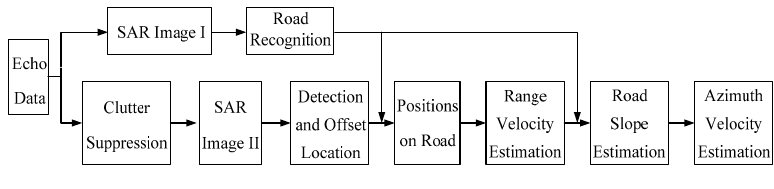
Figure 4. Flow chart of the proposed GMTI method.